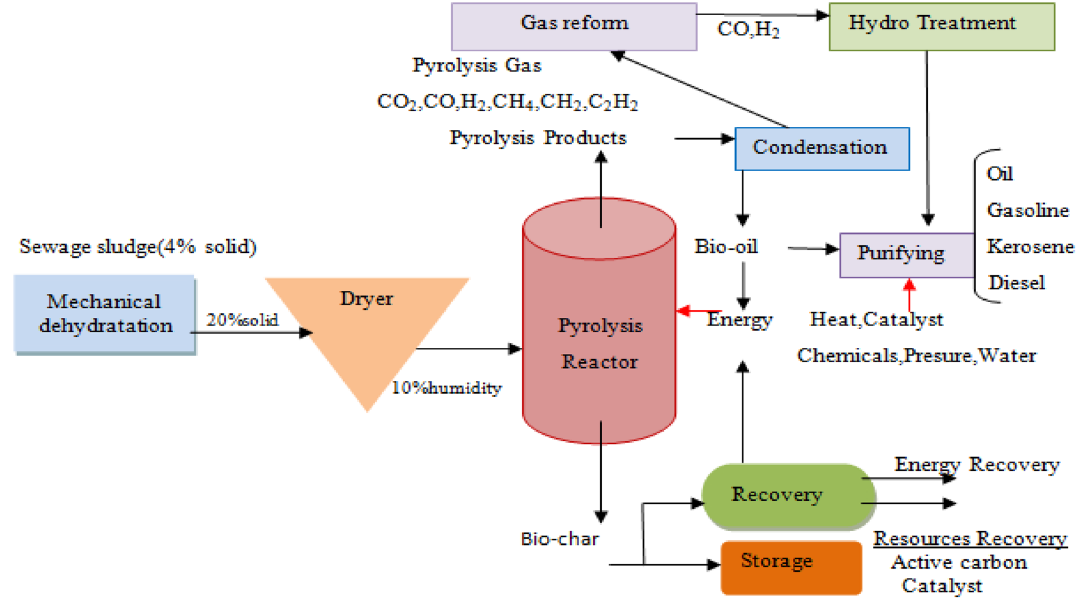
Fig. 5 Pyrolysis of sewage sludge according to